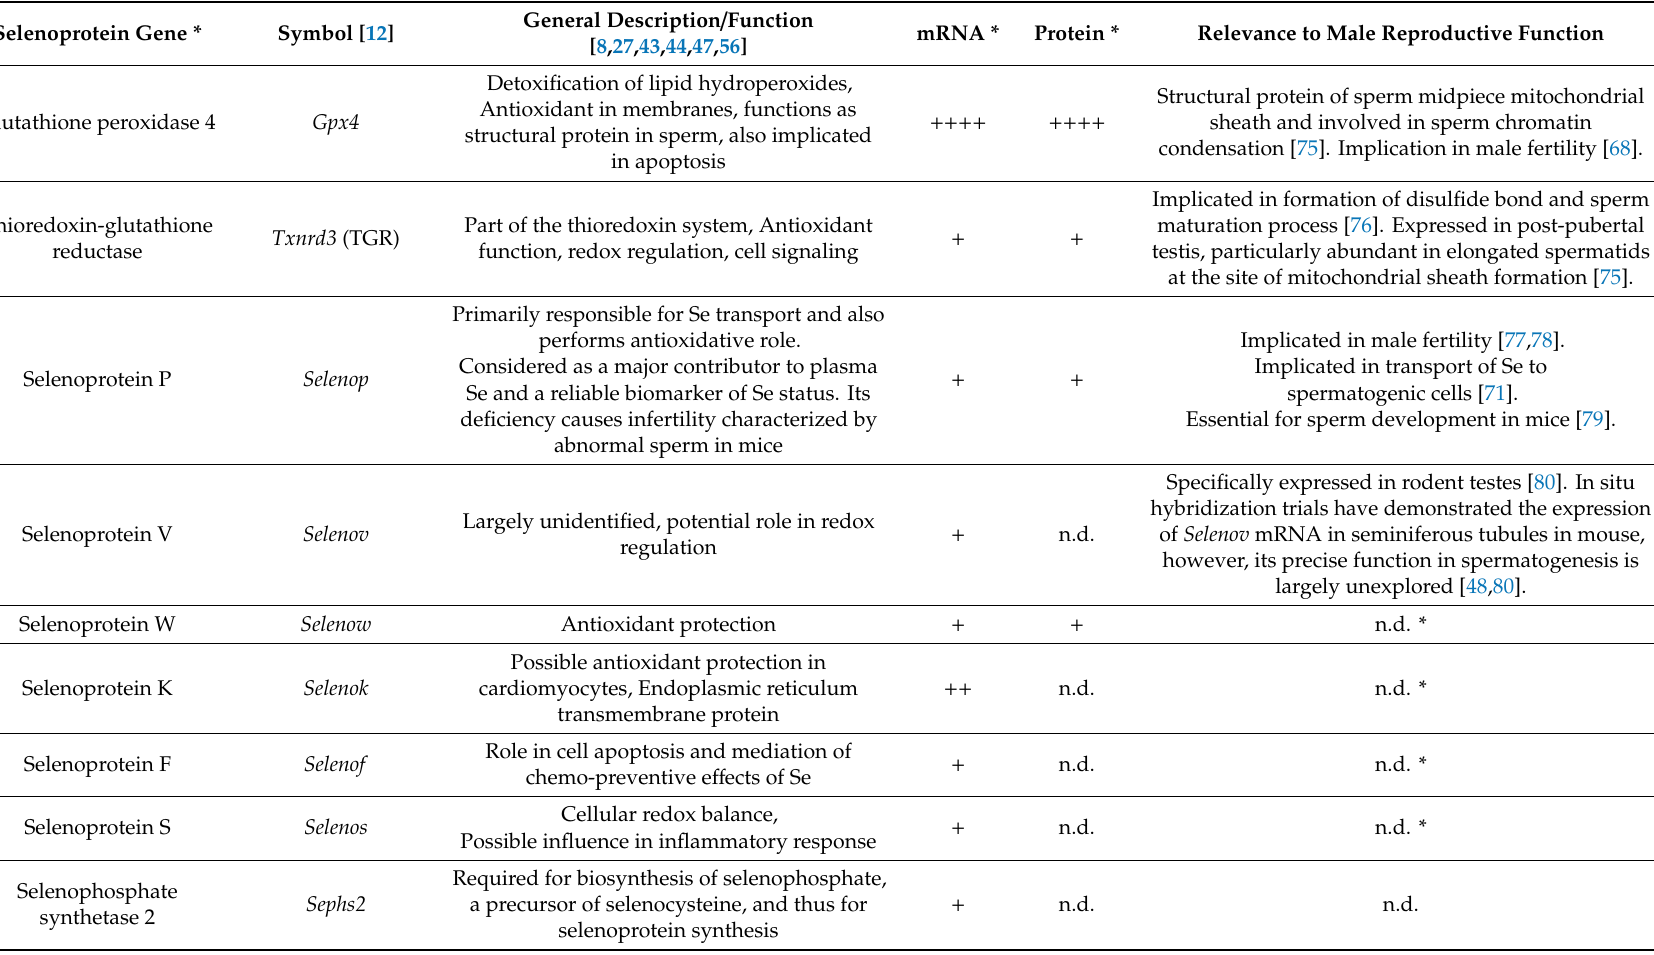
Table 3. Brief description of known mammalian selenoproteins relevant to male